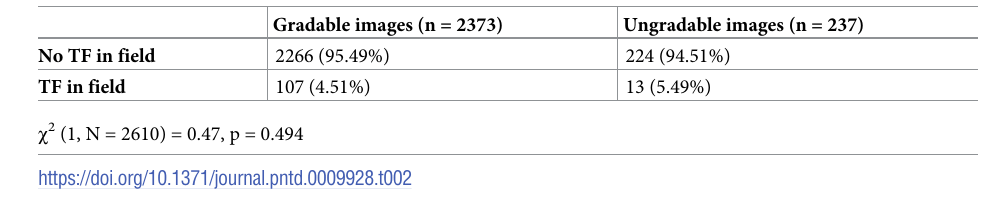
Table 2. Field-assessed prevalence of TF in gradable vs ungradable images in the 2610